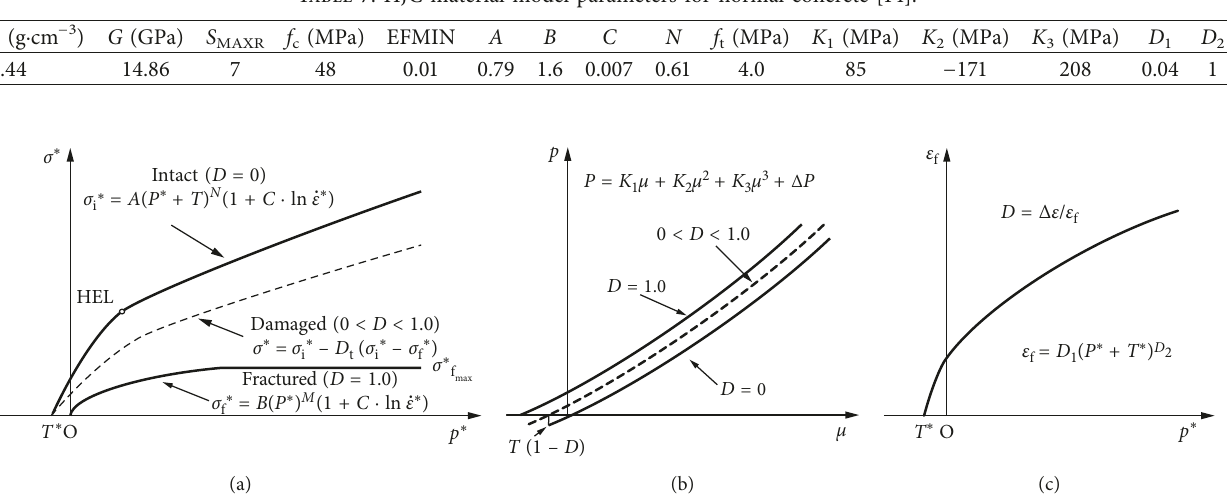
Table 7: HJC material model parameters for normal concrete [14].